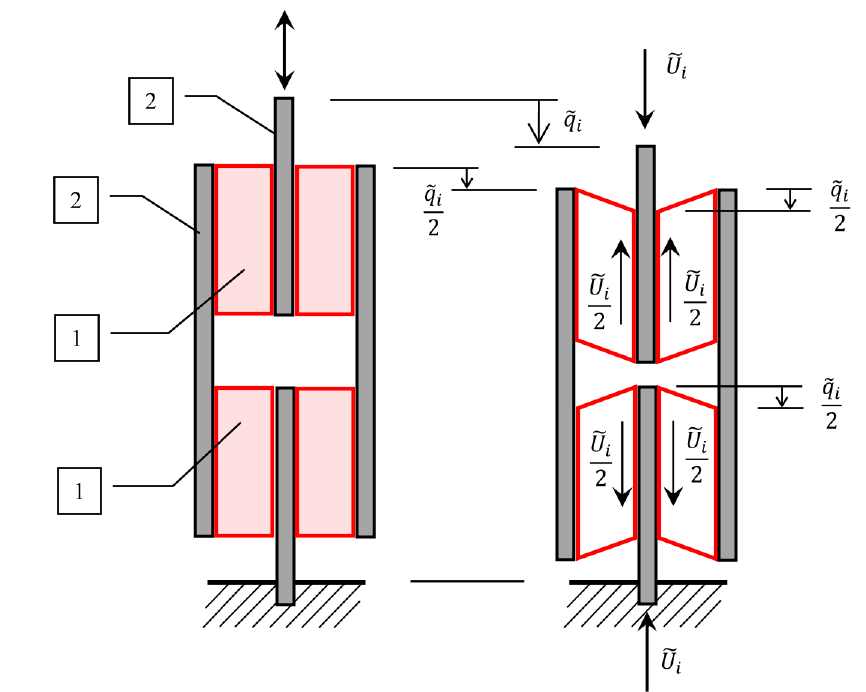
Figure 13. Distribution of forces and displacements in the longitudinal shear test. 1—VE material layer, 2—steel